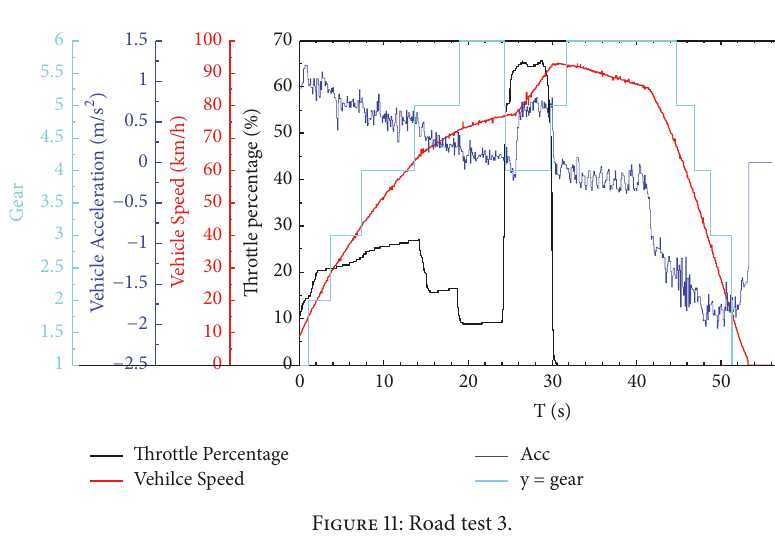
Figure 11: Road test 3.